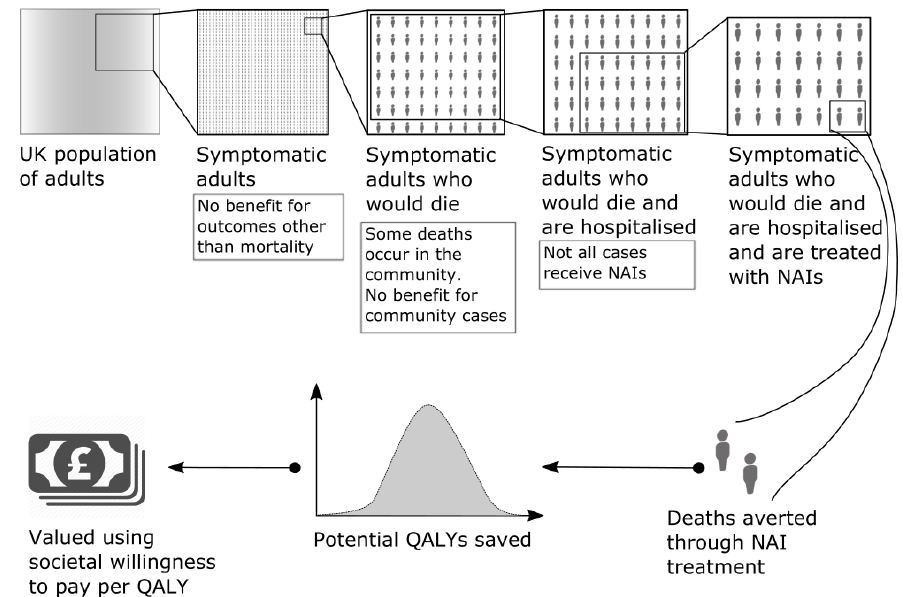
Figure 1. Explanation of the model used to derive the value of the deaths averted due to neuraminidase inhibitor